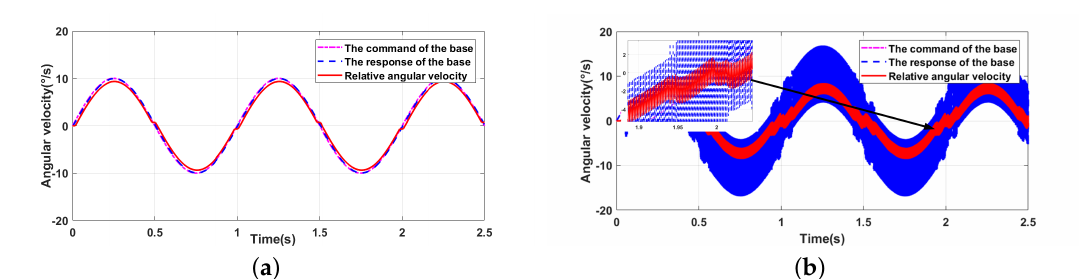
Figure 3. Numerical analysis results. ( a ) Light load with J l = 0.001; ( b ) Heavy load with J l =